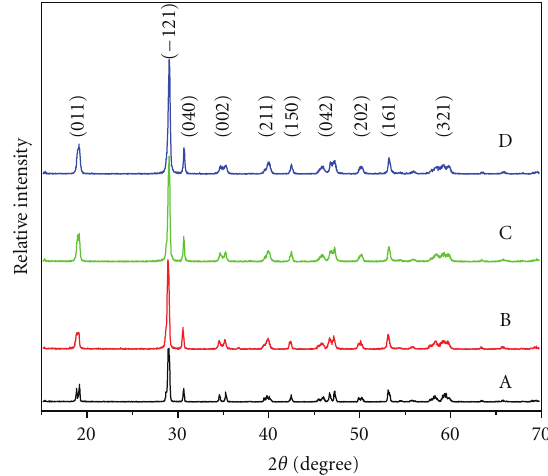
Figure 1: XRD patterns of BiVO 4 samples prepared with di ff erent amount of urea ranging from 0 (A), 3 (B), 6 (C) to 9g (D) at 180 ◦ C for